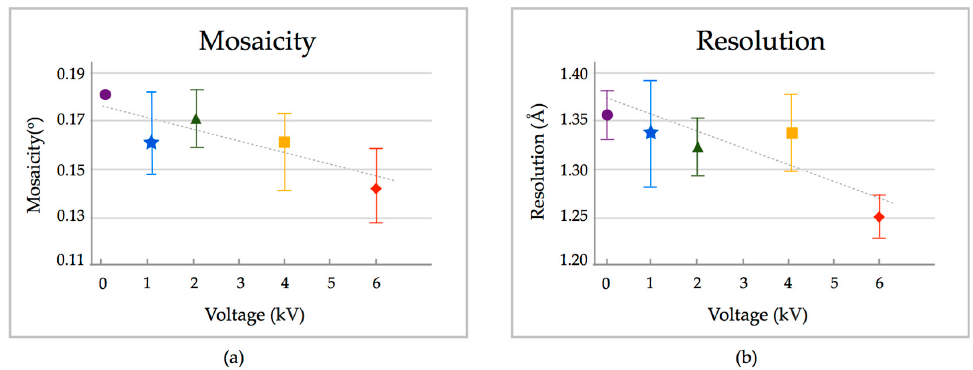
Figure 3. X-ray crystal quality analysis of Glucose Isomerase crystals grown by the microbatch method in the presence of an external DC electric field for 48 h. In total, 75 crystals grown by the microbatch method were probed; five crystals for each field condition. ( a ) Average mosaicity; ( b ) Average diffraction resolution. Color scheme follows that of previous figures; red 6 keV, orange 4 keV, green 2 keV, blue 1 keV and purple 0 keV.